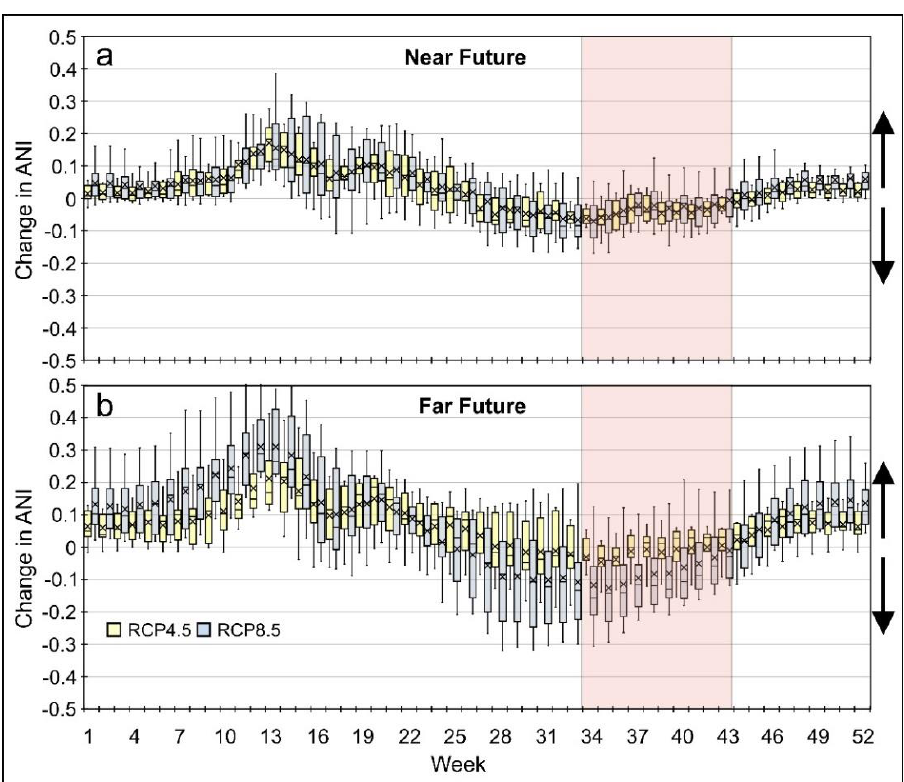
Figure 8. Simulated projected changes in weekly Aboriginal Navigation Index (ANI) under ( a ) near future (2041–2070) and ( b ) far future (2071–2100) periods relative to the historical baseline reference period (1981–2010) derived via hydrological simulations based on 12 sets of climate projections (6 global circulation models × 2 statistically downscaled models) and 2 representative concentration pathways (RCPs 4.5 and 8.5). The fall navigability period is highlighted in transparent red. Over the historical reference baseline spanning 1981–2010, the ANI Fall averaged 0.29, with a fairly wide yearly variation ranging from 0.10 to 0.67 (Figure 9a). As suggested from the findings above for weekly ABF, AXF R , and ANI and in line with the monthly flow finding reported by Dibike et al. [34], the ANI Fall is projected to decrease (a mean of approximately − 0.04 to − 0.03) for the near future period, with a wider spread of decline projected for the far future period mean value for the RCP4.5 (~ − 0.02) and RCP8.5 (~ − 0.08) climate scenarios (Figure 9b). The projected change in ANI Fall is, to some extent, driven by decreases in the early part of this 10-week period (Figure 8). As would be expected from the results of other climate change studies on the Athabasca River Basin [34,36], the inter-model variability in the projected changes in ANI Fall for the far future period and RCP8.5 scenario is higher than for the RCP4.5 or the near future